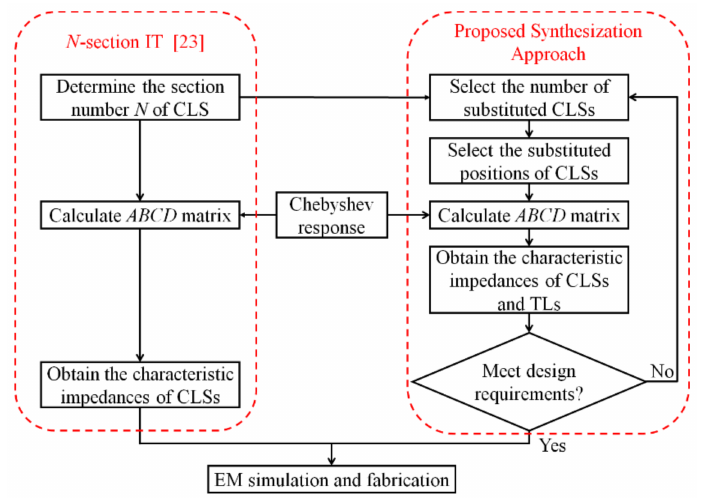
Figure 4. The proposed synthetization approach for N -section